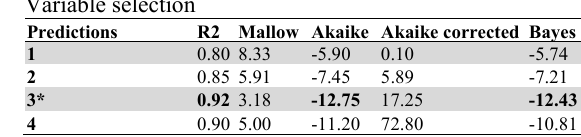
Statistical observations on births, deaths, divorces and con-